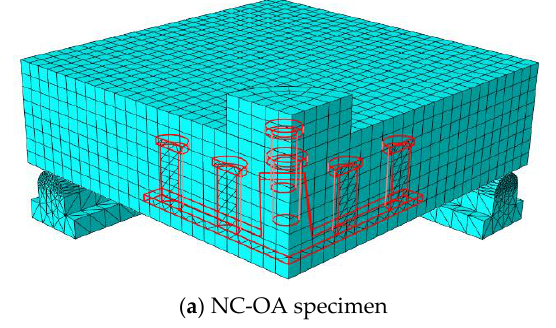
Figure 14. Model of NC-PA slab.